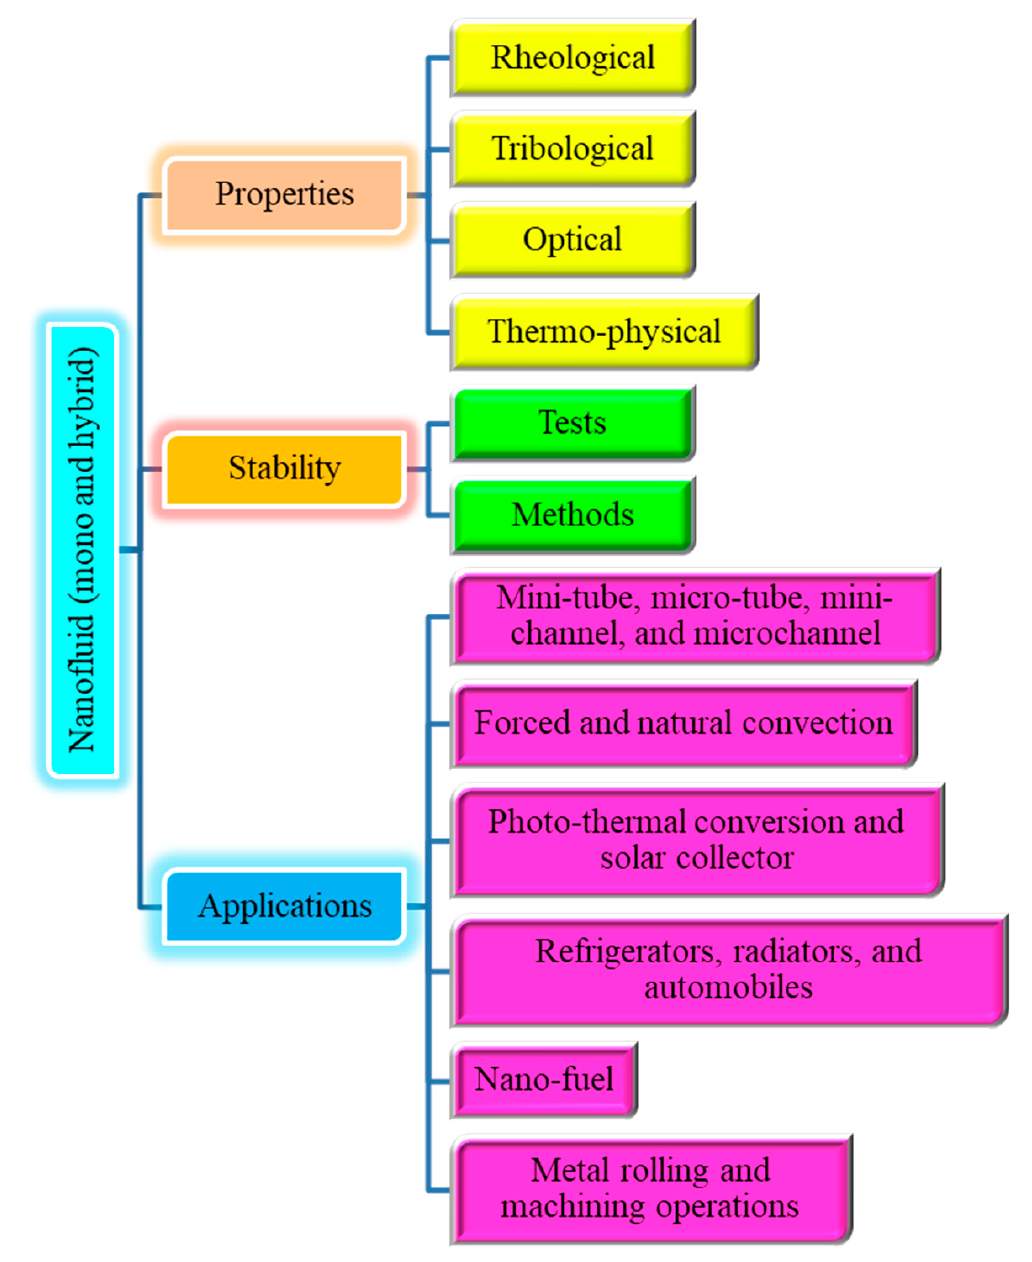
Figure 2. Schematic diagram of this present work.